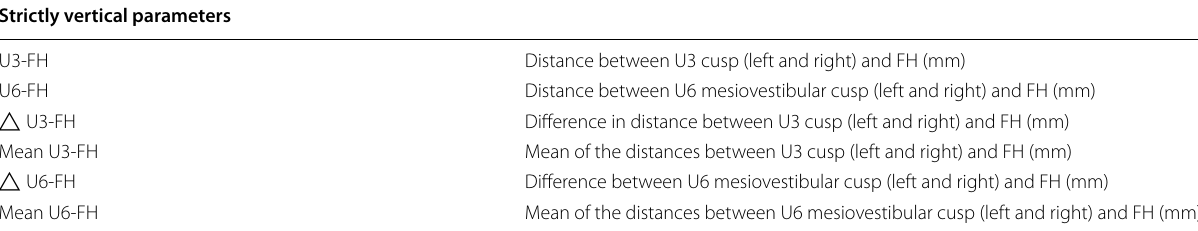
Table 9 Vertical dento-alveolar analysis: vertical parameters Strictly vertical